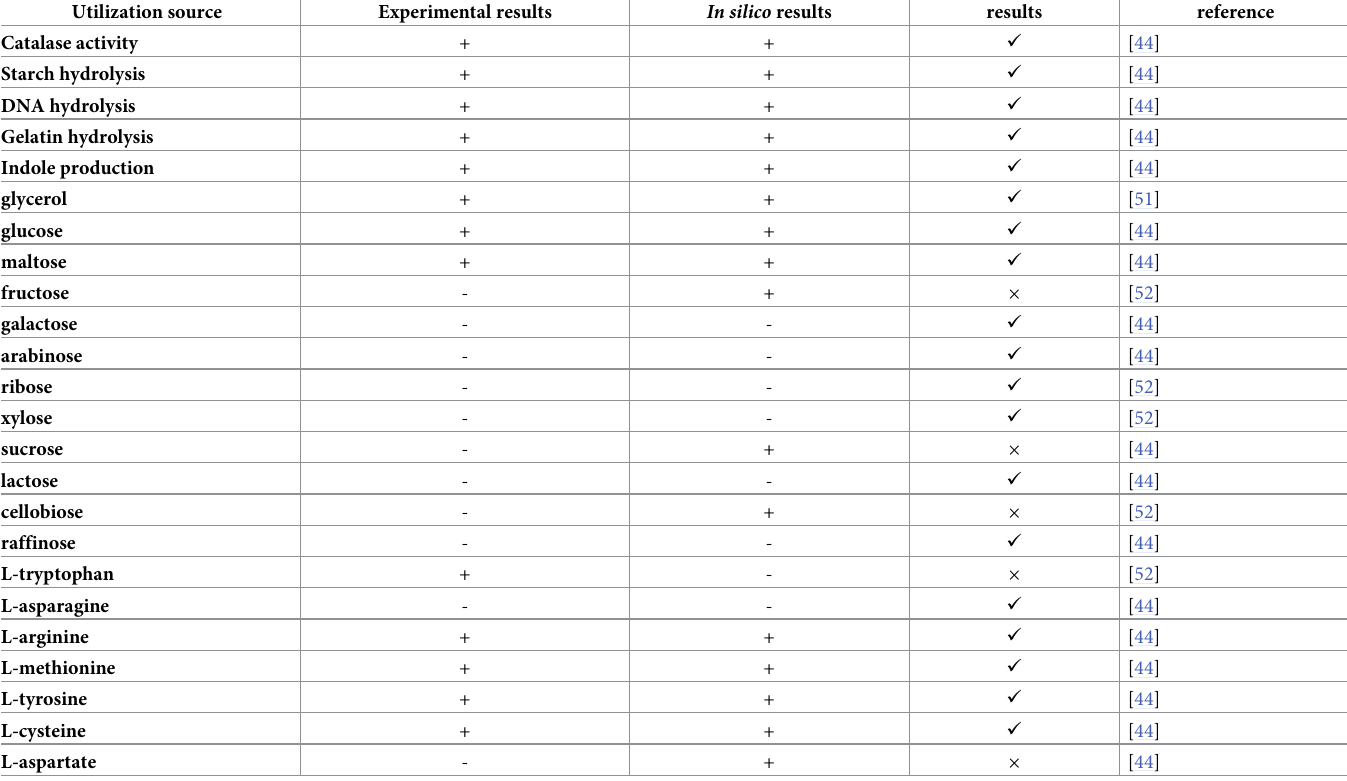
Table 3. Comparison of previously published phenotypes of S . ruber DSM13855and predicted behavior of i